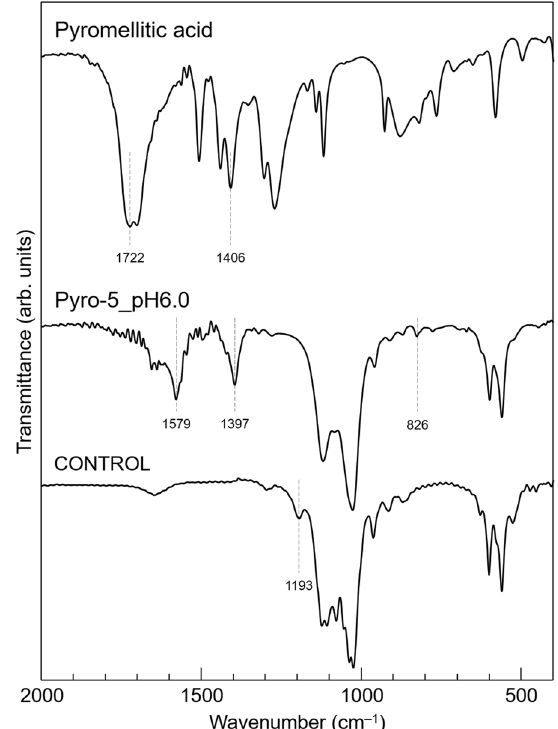
Fig. 5 FTIR analysis. FTIR spectra of plain OCP (CONTROL), OCP with incorporated pyromellitate ions (Pyro5_pH6.0), and pyromellitic acid obtained using the KBr pellet